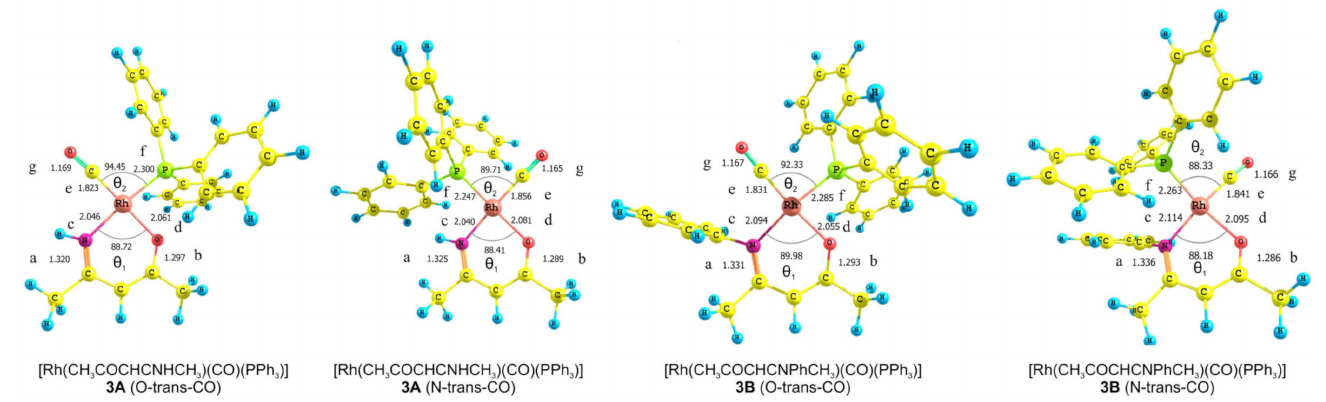
Figure 1. PW91/TZP DFT optimized structures of the possible isomers of the indicated [Rh(N,O- BID)(CO)(PPh 3 )] complexes with selected bond distances (in angstrom) and bonding angles (in